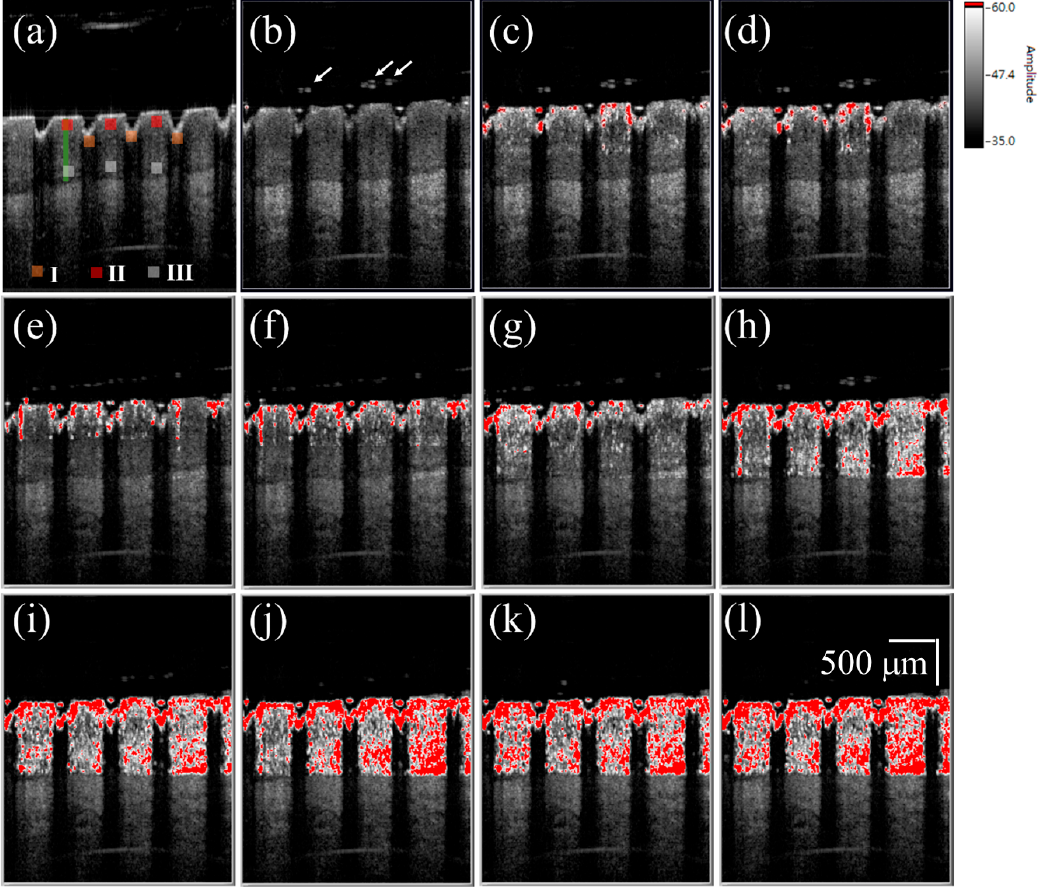
Figure 4. ( a ) 2D OCT image of the nail after 50 mJ laser exposure. Time-series SV-OCT images of the treated nail obtained after the liquid drug application at ( b ) 0 s; ( c ) 0.2 s; ( d ) 0.4 s; ( e ) 0.6 s; ( f ) 0.8 s; ( g ) 1.0 s; ( h ) 2.0 s; ( i ) 4.0 s; ( j ) 6.0 s; ( k ) 8.0 s; and ( l ) 10.0 s. The white arrows indicate the stronger